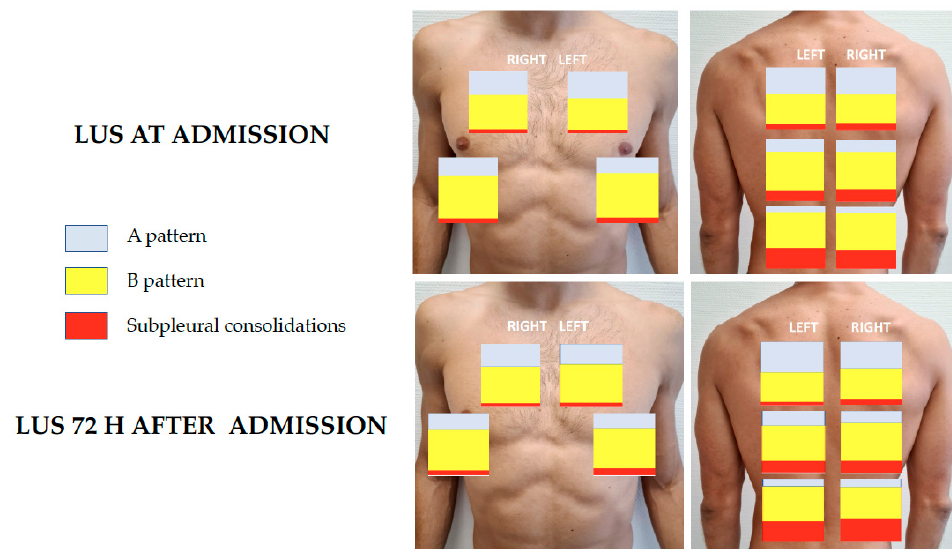
Figure 3. Distribution of LUS findings at admission and 72 h later.